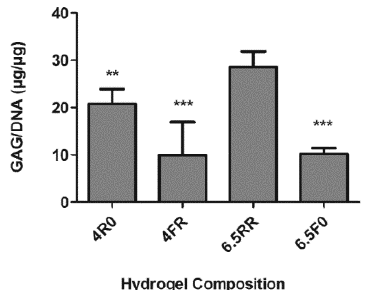
Figure 3. GAG/DNA content of selected PEG hydrogels after four weeks of in vitro chondrogenic stimulation in 4C chondrogenic medium. Hydrogel formulations were chosen based on previous proliferation data and design of experiments (DoE)-based software. Results depicted as mean ± SD ( n = 3; Student’s t -Test ** p < 0.01, *** p < 0.001 when compared to 6.5RR